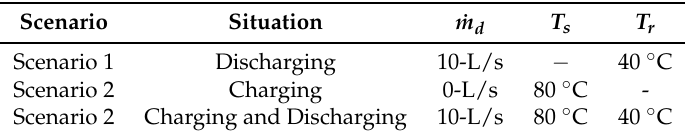
Table 1. Electric boiler (EB) storage model verification scenarios.